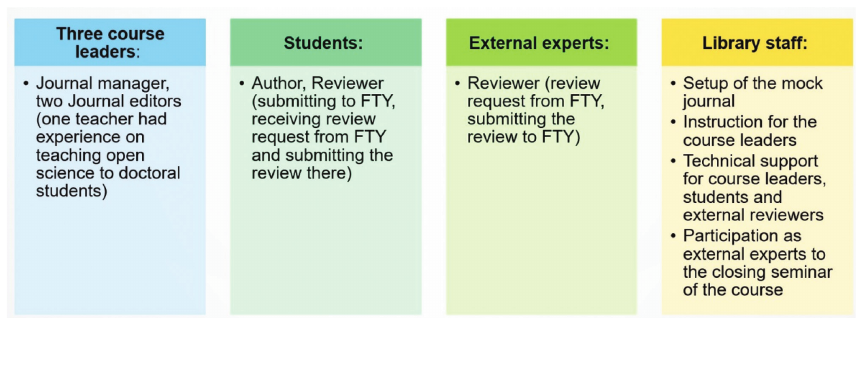
Fig. 3: The different roles of target